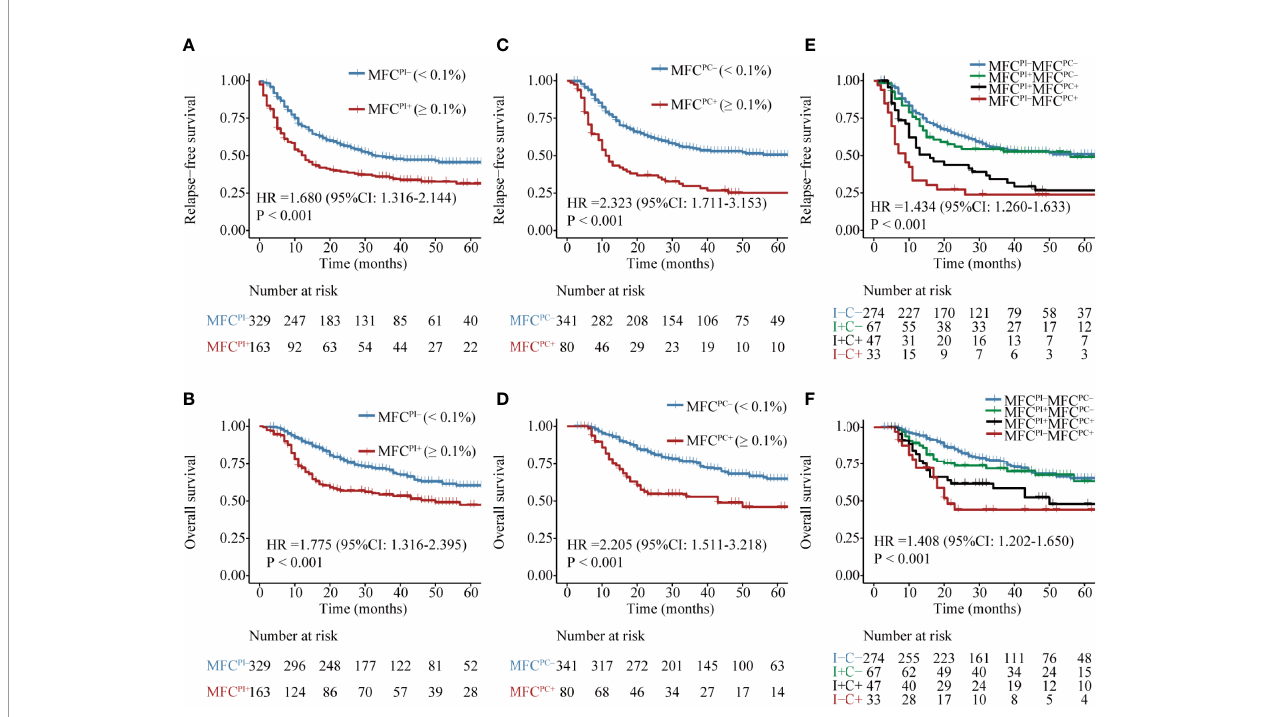
FIGURE 1 | Kaplan – Meier curves for probability of relapse-free survival (RFS) and overall survival (OS) in AML patients. (A, B) RFS and OS based on MFC MRD status post induction. (C, D) RFS and OS based on MFC MRD status post two consolidation cycles. (E, F) RFS and OS based on MFC MRD status in the combination of both time